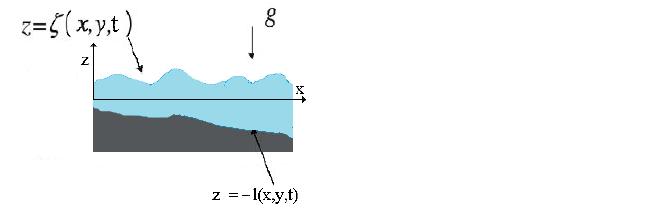
Figure 1. The geometry of the flow where ζ ( x , y , t ) is the wave height and l ( x , y , t ) is the seabed function,